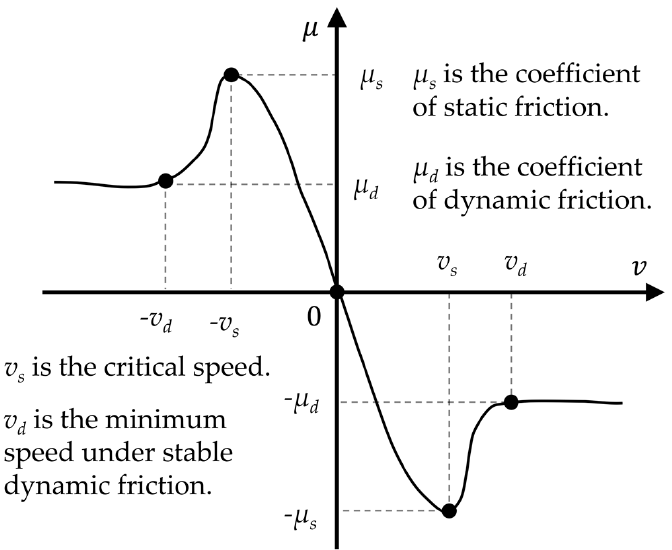
Figure 7. Coulomb friction model.